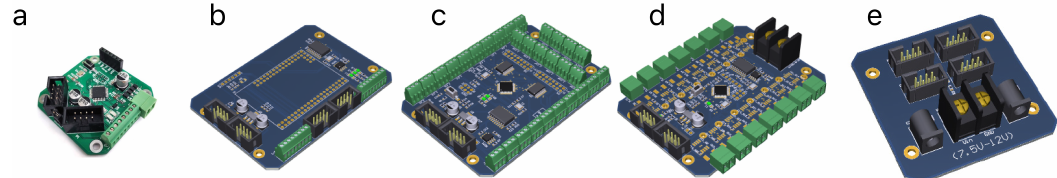
Figure 6. Customized design of different electronic boards. ( a ) Motor drivers for a closed-loop control using encoders. ( b ) Electronic board to supervise the limit switches. ( c ) Central controller to manage all the communications. ( d ) 24 V power board to supply the motors. ( e ) 9 V power board to supply energy to the rest of electronic